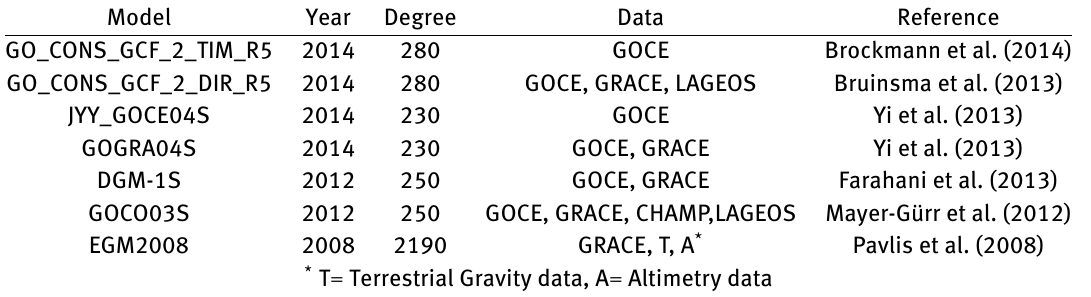
Table 2: Overview of the selected GGMs Model Year Data